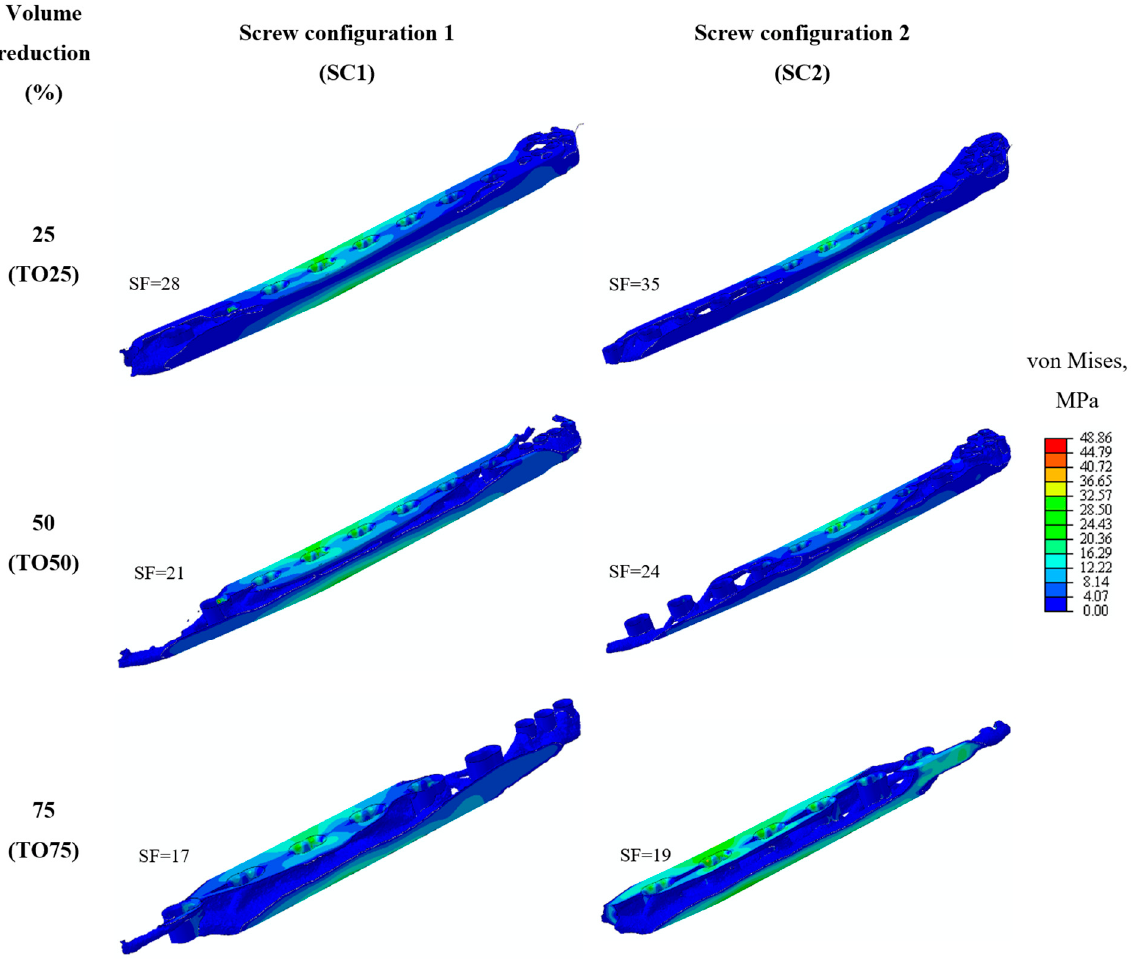
Figure 6. The von Mises stresses on topology optimization plates during spiral fracture fixation.